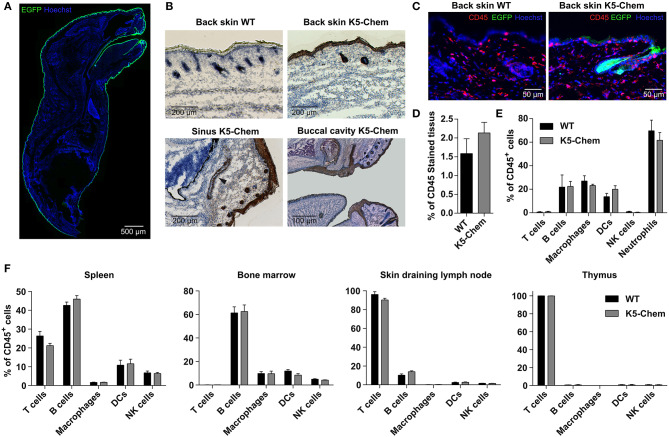
Overexpression of bioactive chemerin in skin does not affect leukocyte populations in skin and lymphoid organs. (A,B) Whole newborn mice were pre-fixed for 48 h in 4% paraformaldehyde, embedded in OCT and sagittal sections were made. (A) Reconstitution of a sagittal section of a K5-chemerin mouse, with EGFP intrinsic fluorescence in green and cell nuclei stained in blue (Hoechst). (B) Cryosections were stained by immunohistochemistry for EGFP (brown) and counter-stained by hematoxylin-eosin. Upper panels show the back skin of control (left) and K5-chemerin (right) mice. Lower panels illustrate sections through sinus cavities (left) and a partial reconstitution of the buccal cavity (right) of K5-chemerin mice. Black arrowhead indicates the location of the sinus. (C) Skin cryosections from control (left) and K5-chemerin (right) mice showing CD45 staining (red), EGFP fluorescence (green), and nuclei (Hoechst, blue). (D) The relative surface of CD45+ staining in skin sections was measured and graphed (mean ± SEM, n = 5 mice per group). (E,F) Skin samples (E), thymus, skin draining lymph nodes, bone marrow and spleen (F) were collected from control and K5-chemerin mice and digested. The cell suspensions were stained with combinations of antibodies and analyzed by flow cytometry. The percentage of CD45+ cells and the proportion of various leukocyte subsets (% of CD45+ cells) are represented, including T cells (CD3+ CD4+ and CD3+ CD8+), B cells (CD3− B220+), neutrophils (Ly6G+ CD11b+) macrophages (CD11b+ CD11c−), DCs (CD11c+) and NK cells (CD3− NK1.1+). The results are from a representative experiment (mean ± SEM, n = 5 mice per group).